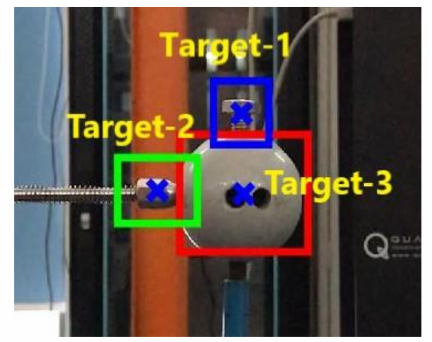
Figure 4. Definition of three target areas in the first frame image.